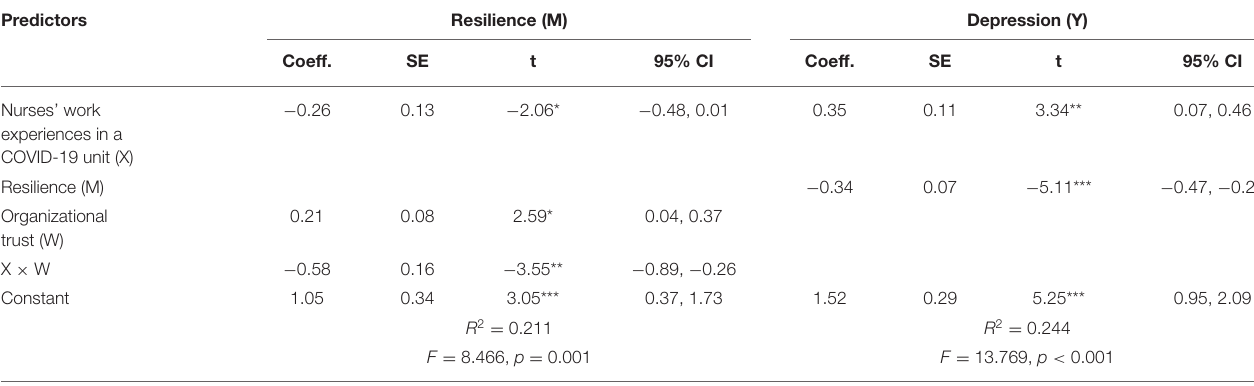
TABLE 2 | Unstandardized regression coefficients estimating resilience and depression ( N =